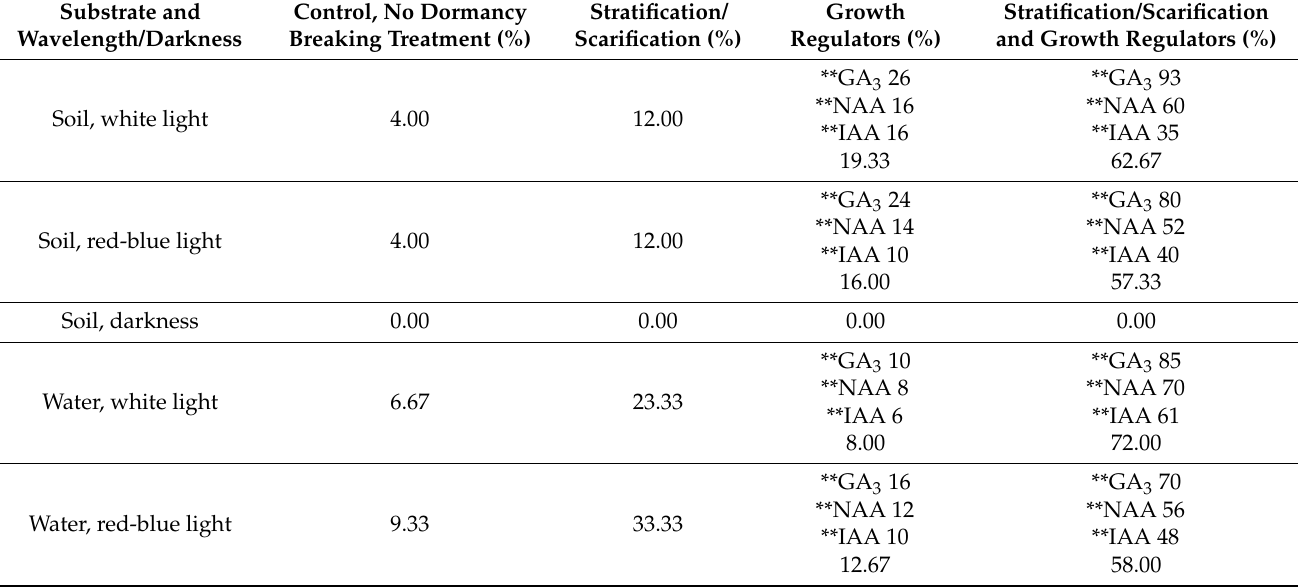
Table 2. Germination mean (%) of pelleted Scots pine seeds in relation to substrate, wavelength, and dormancy breaking